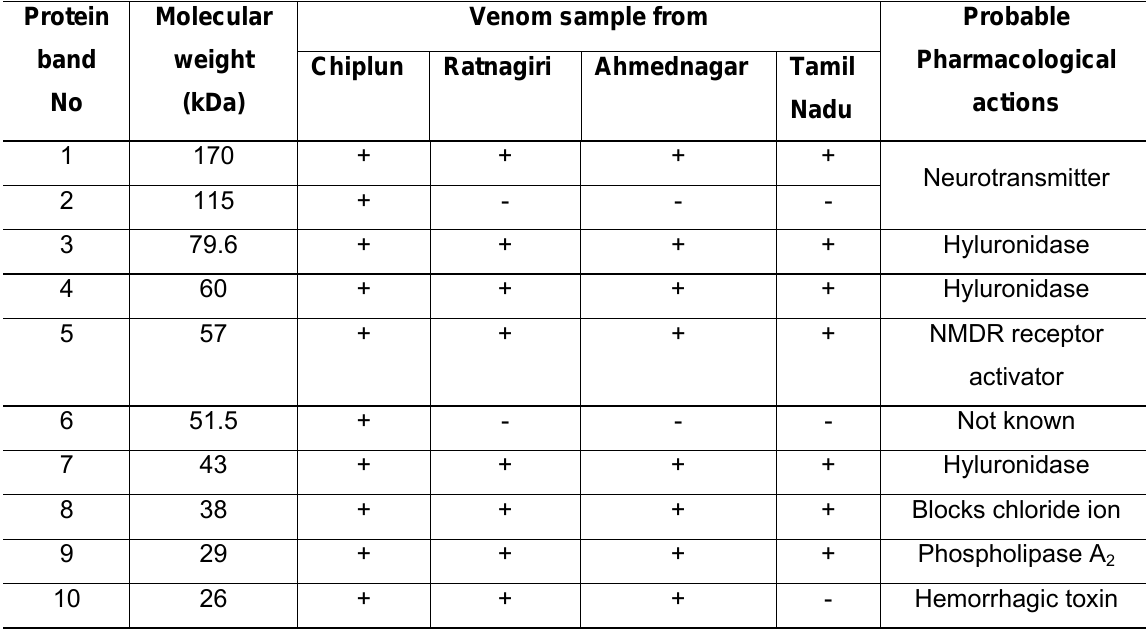
Table 1: Molecular weights of resolved bands of scorpion venom samples, calculated through comparison with the standard molecular weight markers, and their known probable pharmacological